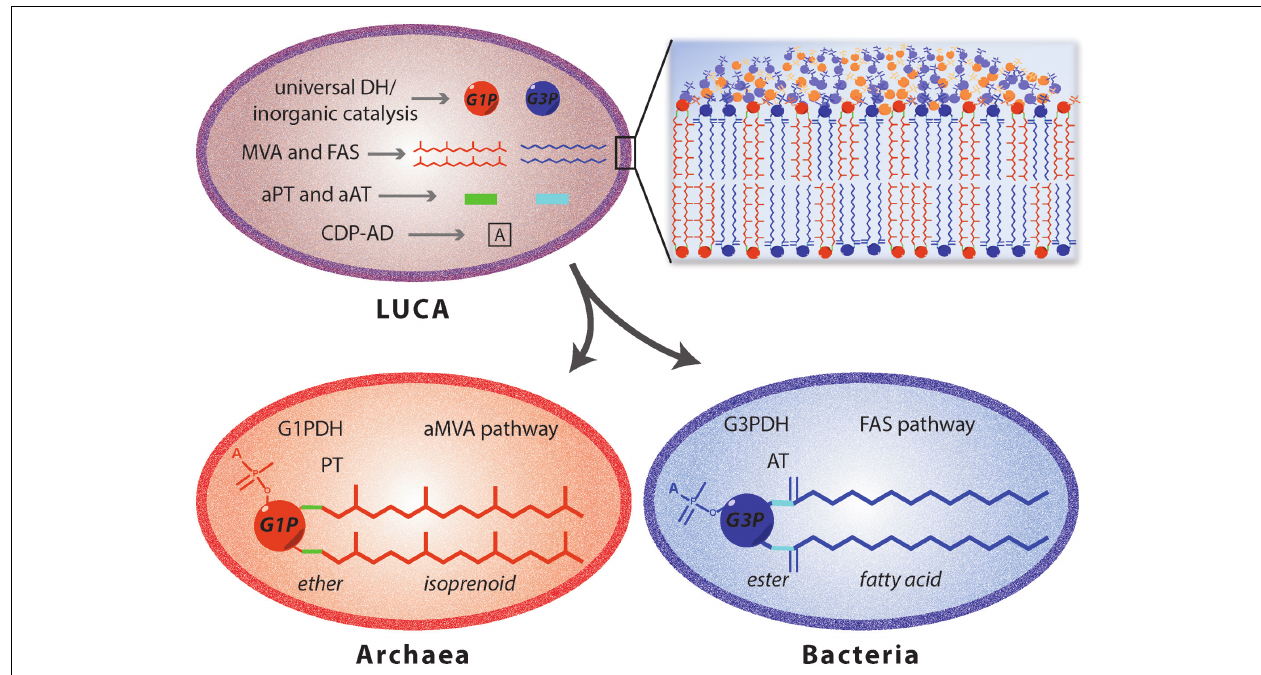
FIGURE 6 | Proposed evolutionary model forArchaea and Bacteria differentiation. The existence of a cenancestor (LUCA) embordered by a mixed membrane is one of the main theories of organism’s evolution.This primordial organism would be characterized by the presence of heterogeneous enzymes involved in the synthesis of archaeal and bacterial lipids. Enzyme separation occurred by environmental pressures leading to the